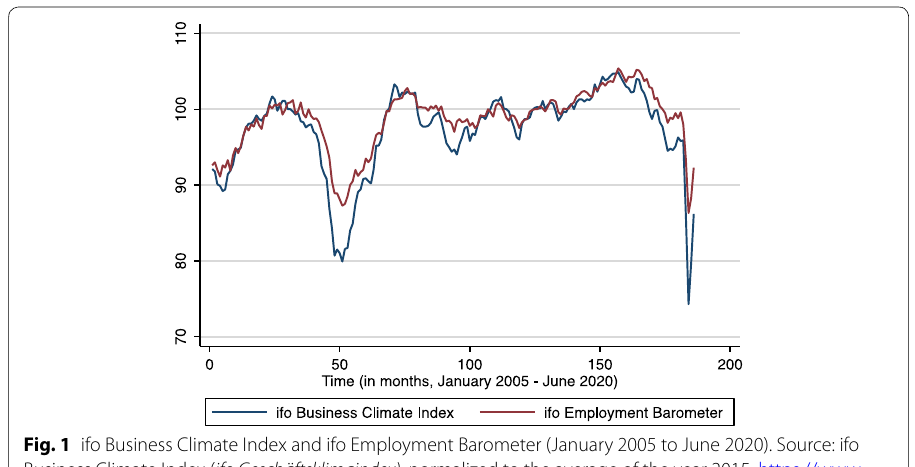
Fig. 1 ifo Business Climate Index and ifo Employment Barometer (January 2005 to June 2020). Source: ifo Business Climate Index ( ifo Geschäftsklimaindex) , normalized to the average of the year 2015, https ://www. ifo.de/en/surve y/ifo-busin ess-clima te-index , and ifo Employment Barometer (ifo Beschäftigungsbarometer), normalized to the average of the year 2015 , https ://www.ifo.de/en/surve y/ifo-emplo yment -barom eter;